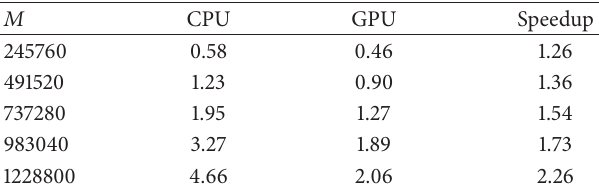
Table 2: Performance comparison between optimized GPU solu- tion on Quadro FX 5800 and parallel CPU solution on E5540 with fixed 𝑁 = 128 .